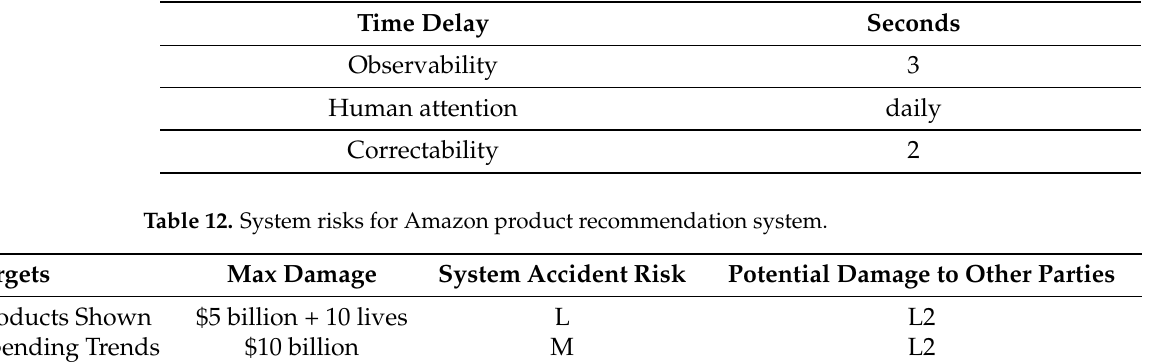
Table 11. Time delay, human attention, and correctability for Amazon’s recommendation system.